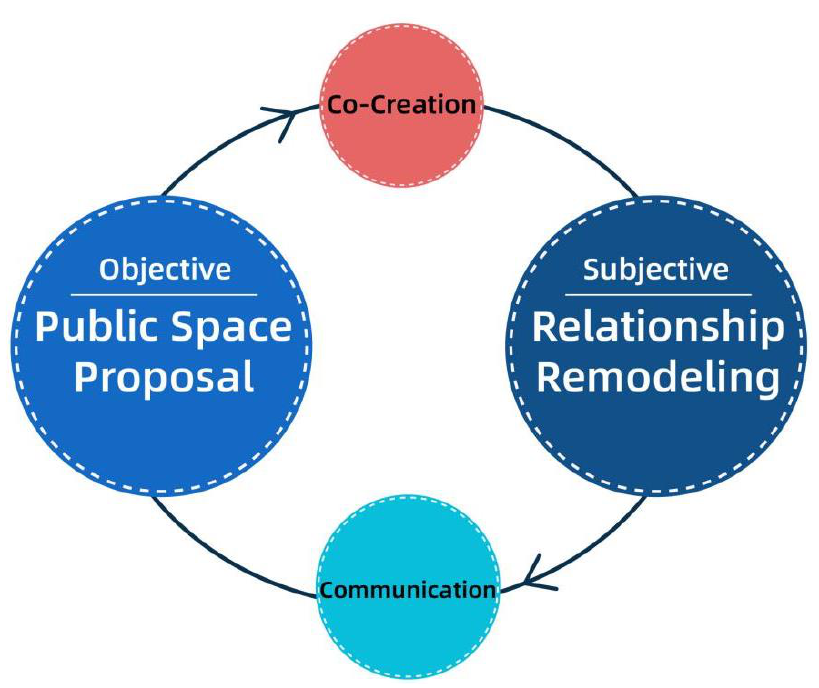
Figure 4. Core framework of co-creation workshop.